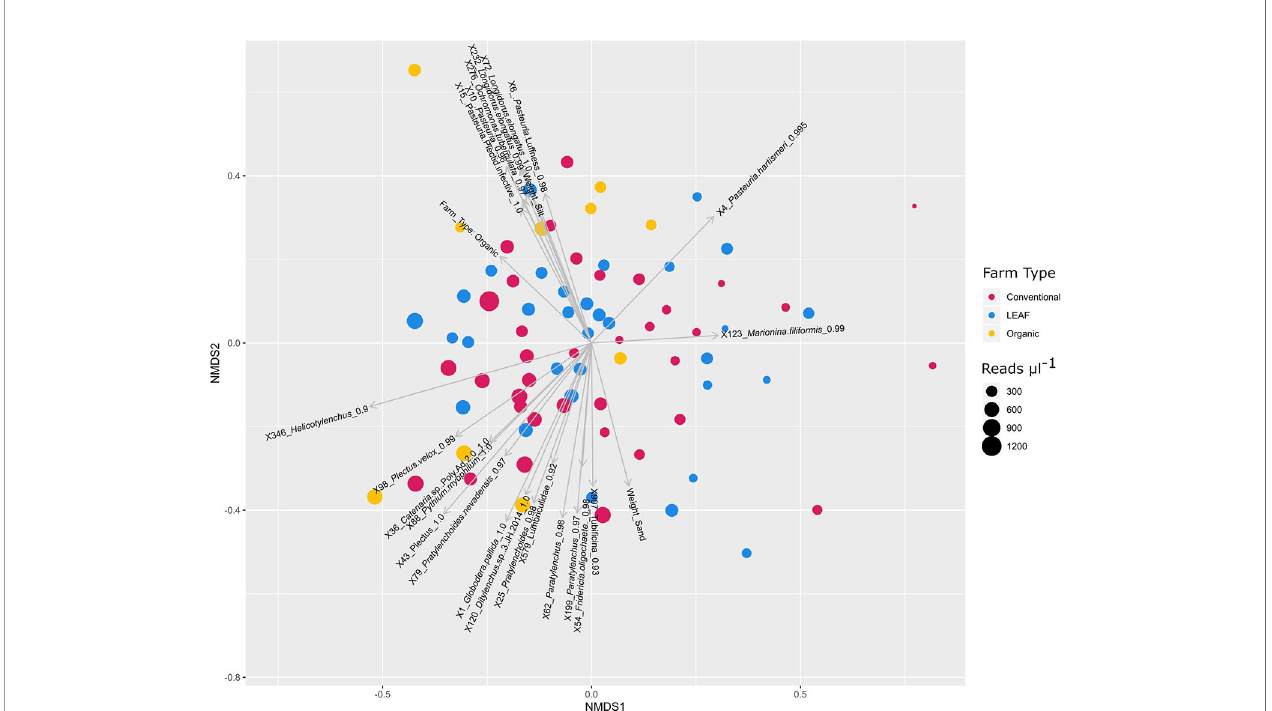
FIGURE 5 | NMDS ordination of ESFN nematode community ZOTUs. Each point represents a nematode community. Samples are colored by farm type and sized by the total abundance of nematode merged read pairs recovered µl − 1 of PCR product added to the fi nal pool. Arrows represent the statistically signi fi cant fi ts of Nematode ZOTUs, Pasteuria ZOTUs, non-nematode metazoan ZOTUs, and environmental factors where the length of the arrow re fl ects the effect size. For ease of visualization the number of signi fi cant nematode ZOTUs plotted has been reduced. Stress =